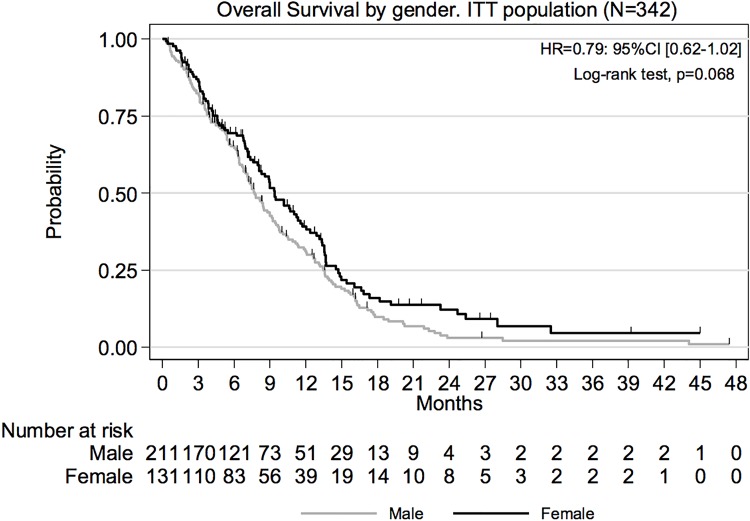
Overall survival by gender, ITT population.